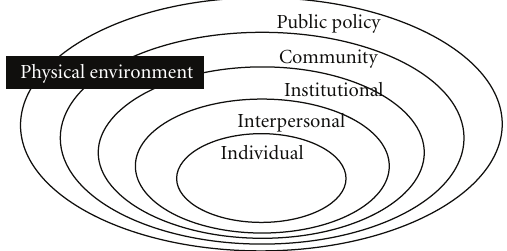
Figure 1: Healthy aging research network social ecological model of healthy aging